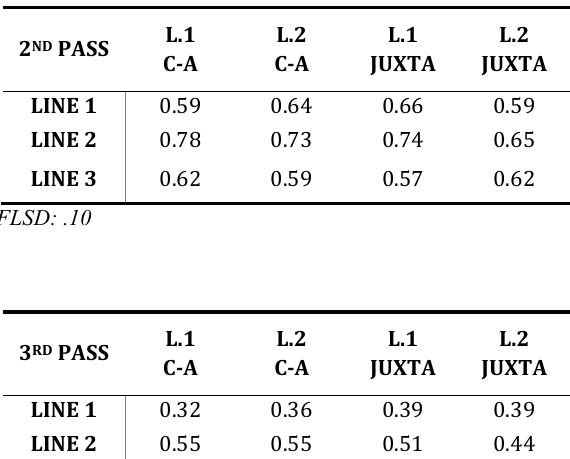
Supplementary Table S1. Likelihood with which a line is fixated in second- and third-pass reading (upper and lower half of the table, respectively). FLSD: Fisher Least Square